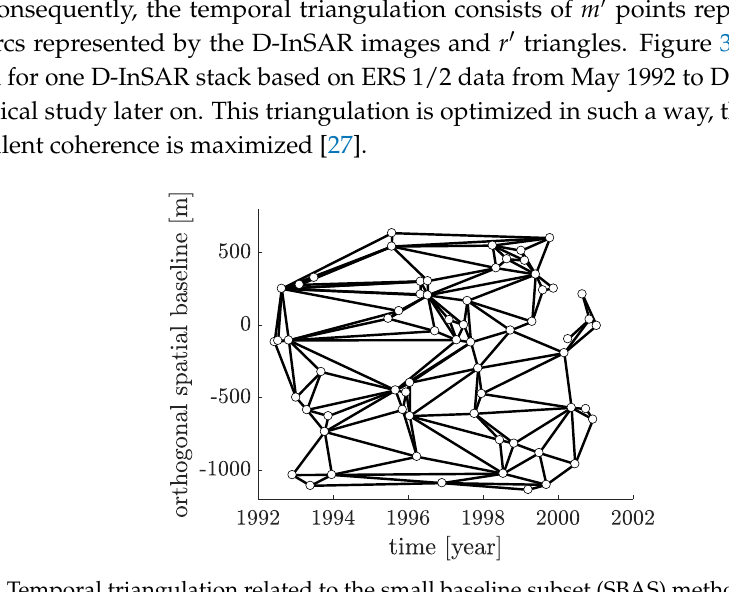
Figure 3. Temporal triangulation related to the small baseline subset (SBAS) method. The white dots represent the individual SAR scenes at the individual acquisition times with corresponding orthogonal spatial baseline relating to the master scene. The black lines represent the